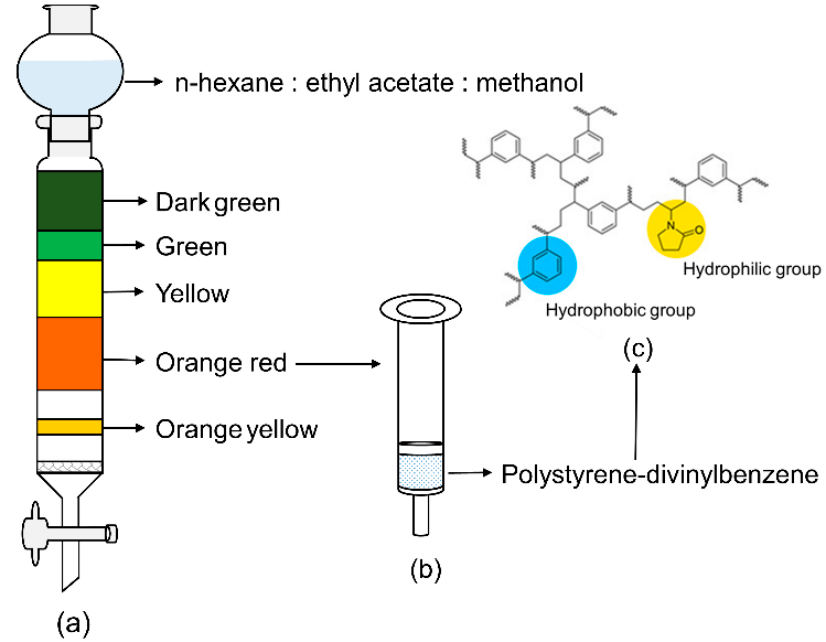
Figure 2. Isolation and purification of fucoxanthin from crude pigments extraction of Phaeodactylum tricornutum . ( a ) SGCC; ( b ) HLB solid-phase extraction column; ( c ) chemical structure of polystyrene-divinylbenzene.